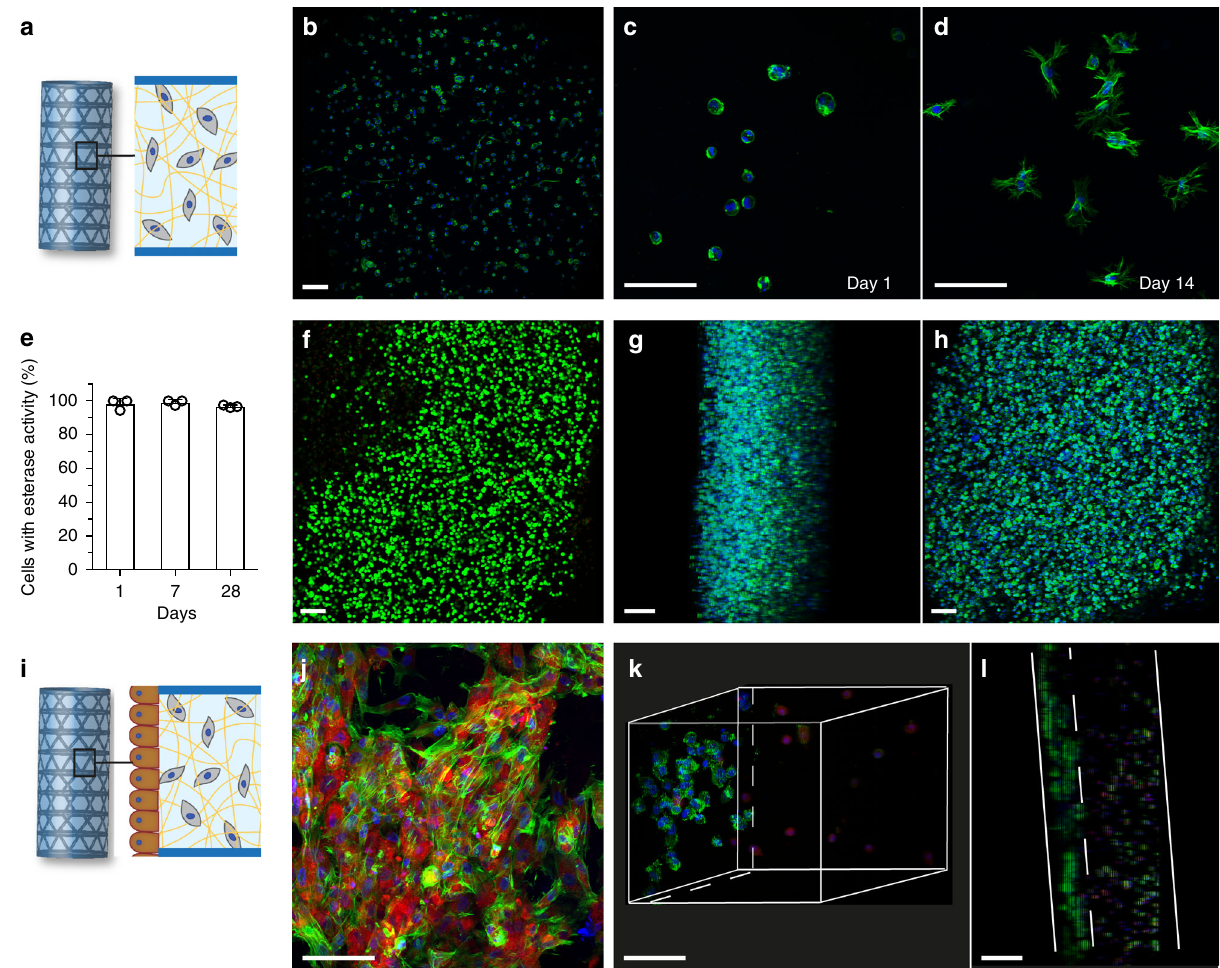
Fig. 6 Cell-laden multicomponent scaffolds. a Schematic of cell encapsulation within the hydrogel coating of the multicomponent devices. b 475 μ m Z - stack of a single, excised window 24 h after MRC-5 lung fi broblasts were encapsulated in 7.5 wt% methacrylated gelatin hydrogel coating (1 × 10 6 cells mL − 1 ). Cell nucleus was labeled with NucBlue (blue) and actin cytoskeleton was labeled with Alexa Fluor TM 488 Phalloidin (green). c MRC-5 cells 1 day after